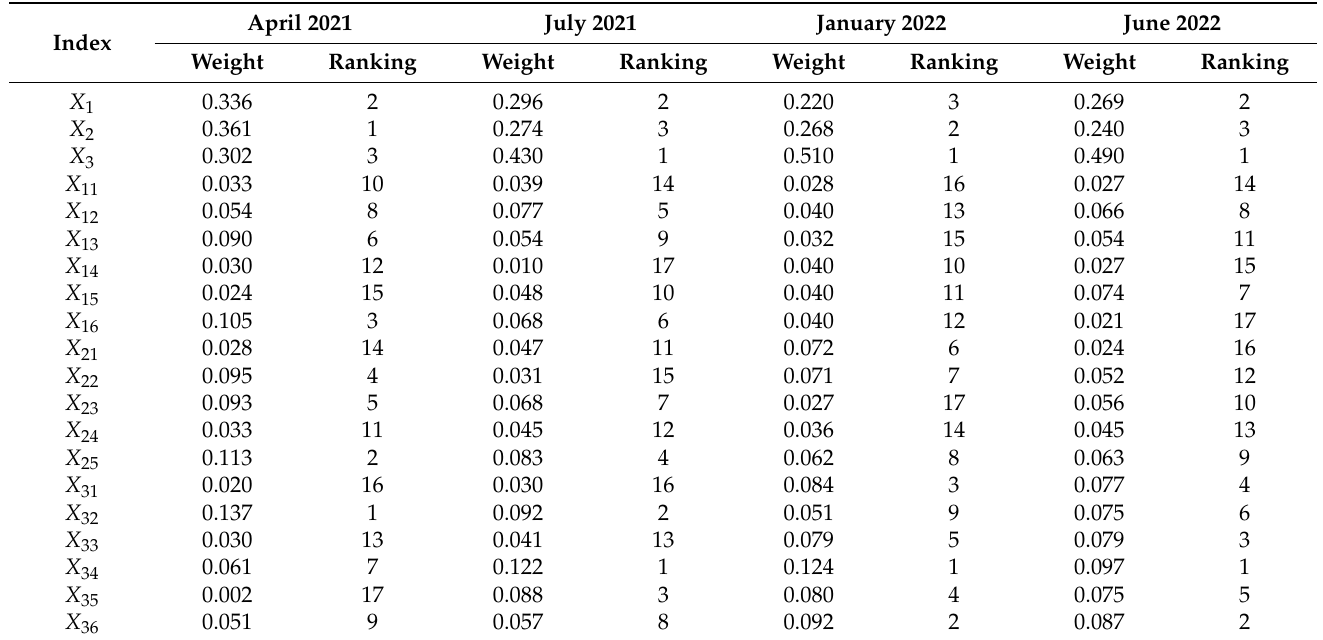
Table A8. Calculation of index weights at different time points.